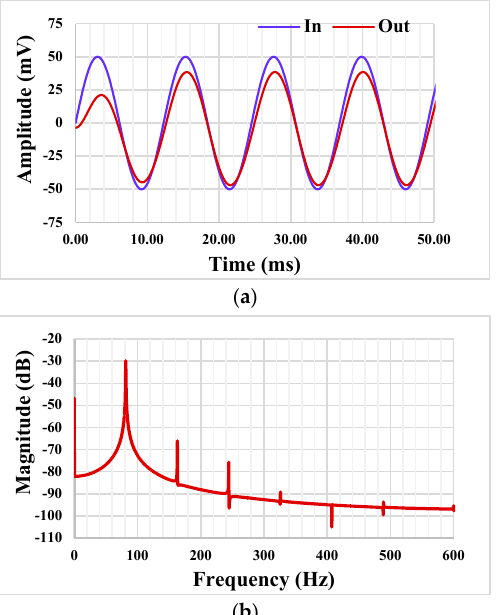
Figure 13. The transient response of the BPF ( a ) and the spectrum of the output signal ( b ). The electronic tuning capability of the LPF, BPF, HPF, and BSF with different bias currents, I set = 0.125, 0.25, 0.5, and 0.75 µ A, is shown in Figure 14. The f o was in the range of 21.11 Hz, 41.63 Hz, 81.47 Hz, and 115.74 Hz, respectively.